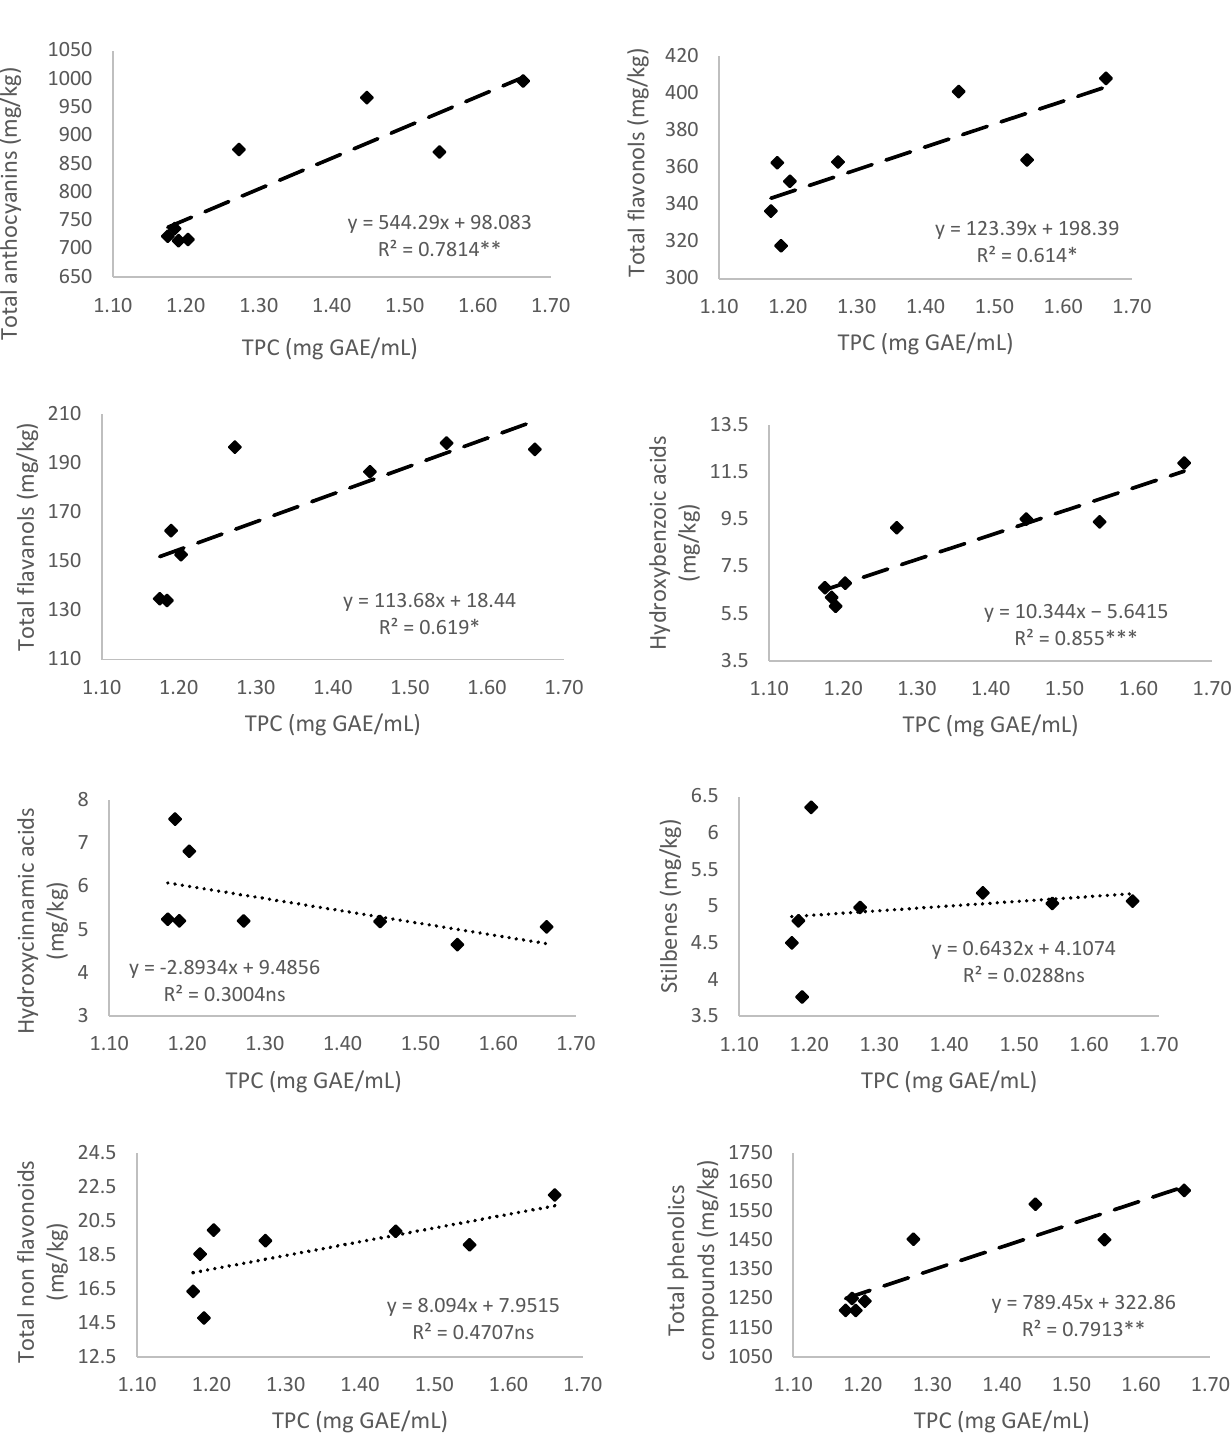
Figure 2. Relationship of the total phenolic content (TPC) (mg GAE/mL) and total anthocyanins, flavonols, flavanols, hydroxybenzoic and hydroxycinnamic acids, stilbenes, non-flavonoids, and content of total phenolic compounds (mg/kg) of Monastrell grapes. Values of the coefficient of determination (R 2 ) are presented. Lines of linear regression are shown: (- - -) when relationships are significant ( p < 0.05, *; p < 0.01, **; and p < 0.001, ***), or ( · · · ) when there are no significant differences ( p > 0.05, ns).